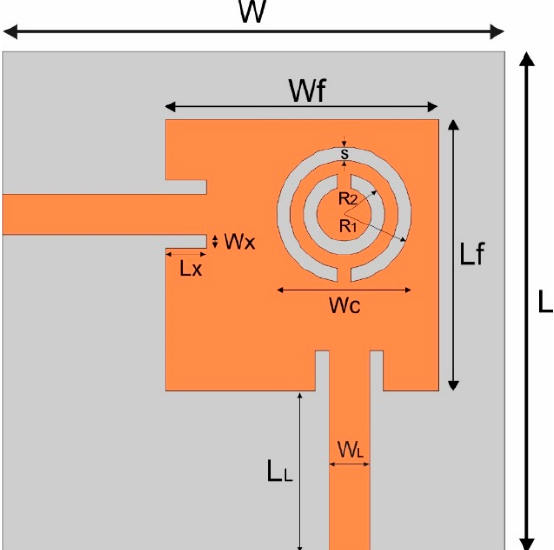
Figure 2. Top view of the proposed microstrip planar circuit geometry on an FR-4 dielectric substrate. Table 1. Proposed microstrip circuit dimensions.